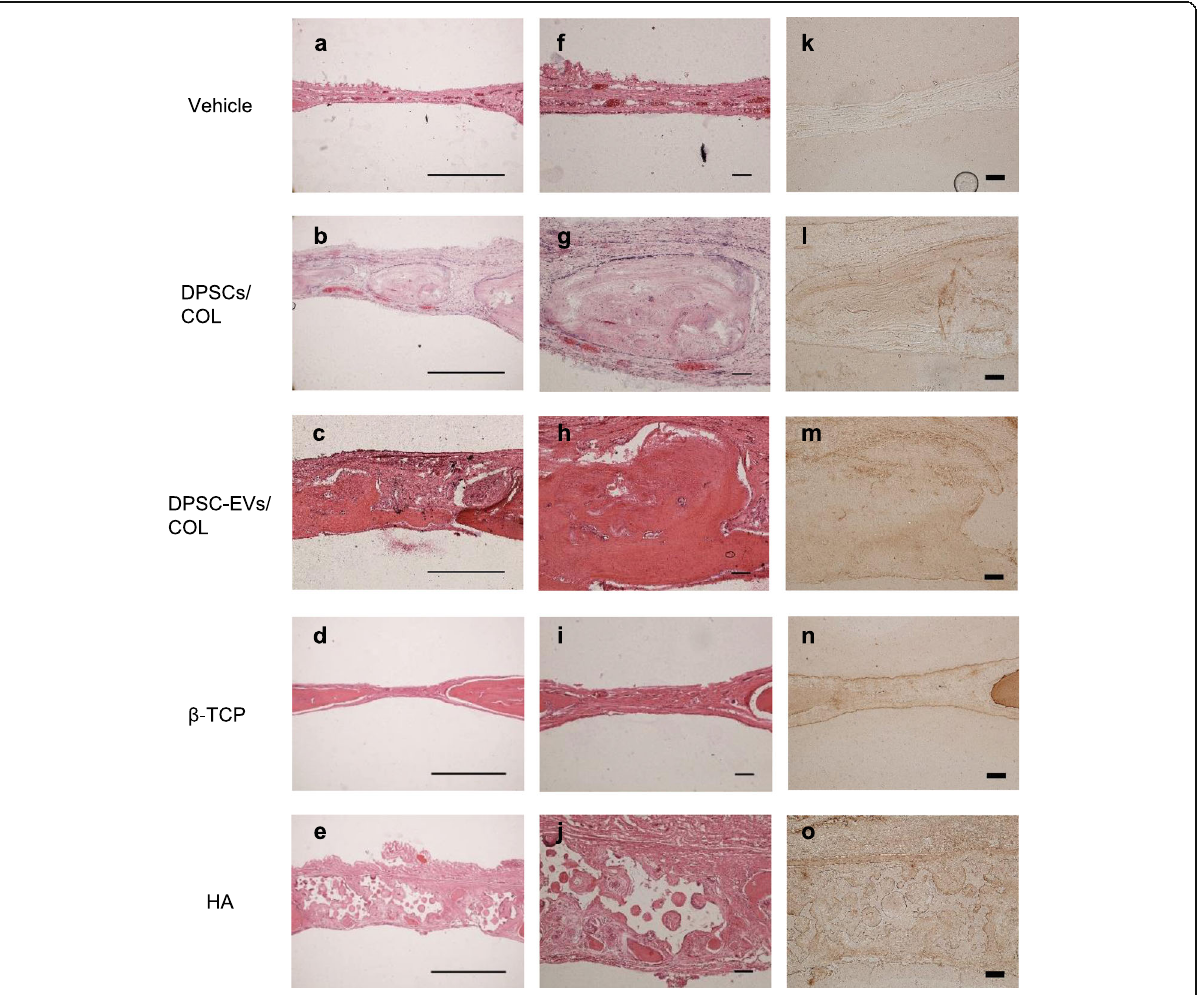
Fig. 4 Histological analysis of the calvarial defect 16 weeks after the procedure. Sagittal sections of parietal bone were stained with hematoxylin- eosin and immunohistochemical staining for osteocalcin. a , f , k Vehicle. b , g , l DPSCs/COL. c , h , m DPSC-EVs/COL. d , i , n β -TCP. e , j , o HA. Left section: × 4 magnification, bar = 1 mm. Middle and Right section: × 10 magnification, bar = 0.1